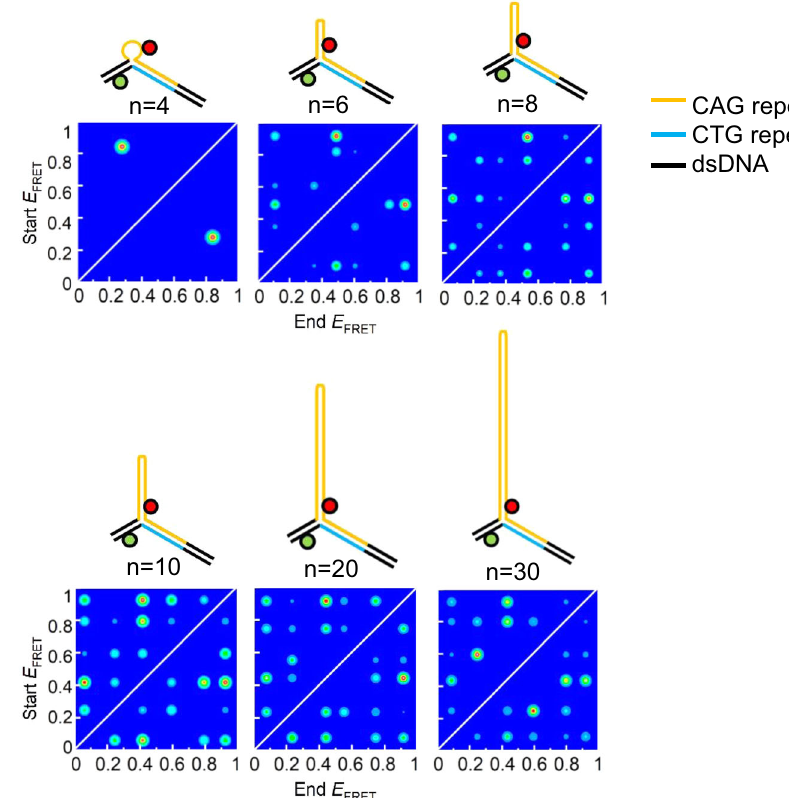
Fig. 3 Dependence of dynamics on repeat length. Transition density plots from TIRF time traces of 3WJs with three complementary CAG (orange) and CTG (blue) repeats in the duplex and (CAG) n slip-outs ( n = 4, 6, 8, 10, 20, and 30). 3WJs with slip-outs of (CAG) 4 have two FRET states, while all other 3WJs are fi tted to six FRET states. Similar plots are found for 3WJs with (CTG) n slip-outs (Supplementary Fig. 20). Measured at 20 °C in a buffer containing 1 mM MgCl 2